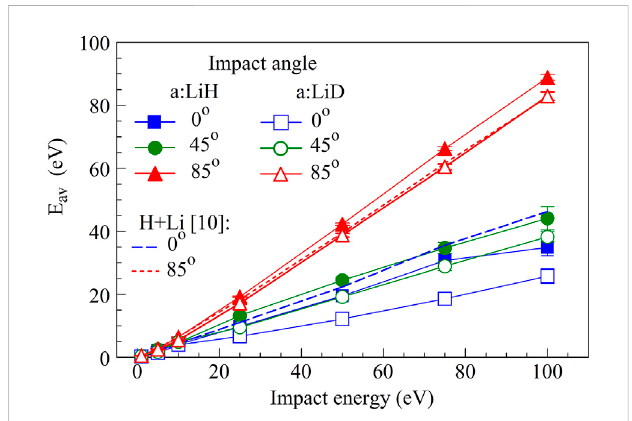
FIGURE 8 Average energies (Eav) of the re fl ected atoms H and D from amorphousLiHandLiDsurfaces,respectively,shownasafunctionofthe incidentenergyforvariousanglesofincidence.Forcomparison,thedata for Eav of H incident at an a:Li surface [10] are shown as dashed lines.